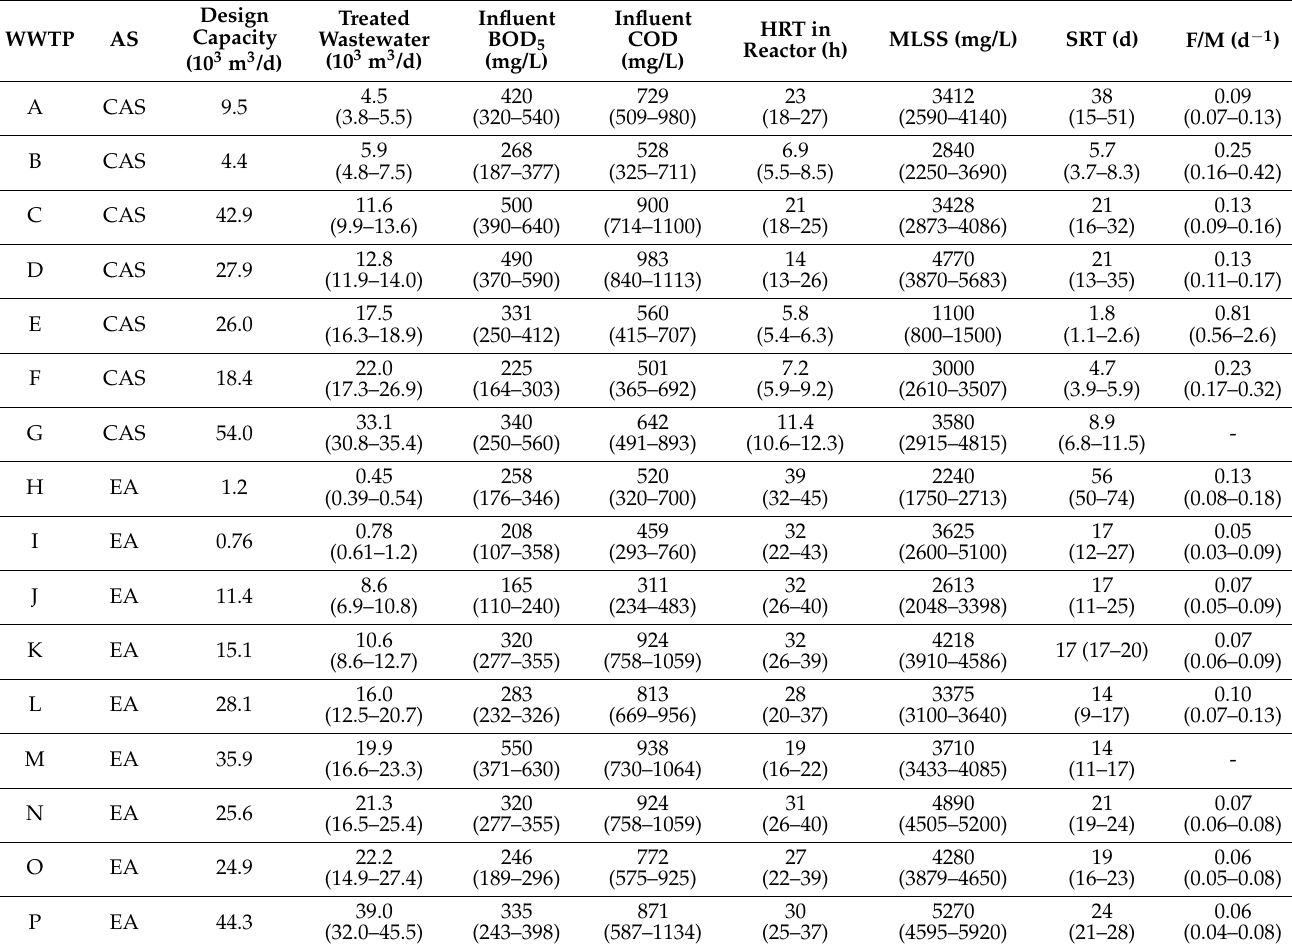
Table 1. Treatment type, designs capacity, and operating conditions of the 16 WWTPs analyzed. Values shown are 5-year medians (P50) and P25–P75 are between